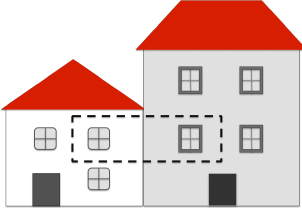
Figure 5. Complex 3D cadastre occurrences in the medieval Coimbra downtown (Portugal): a flat shared by two